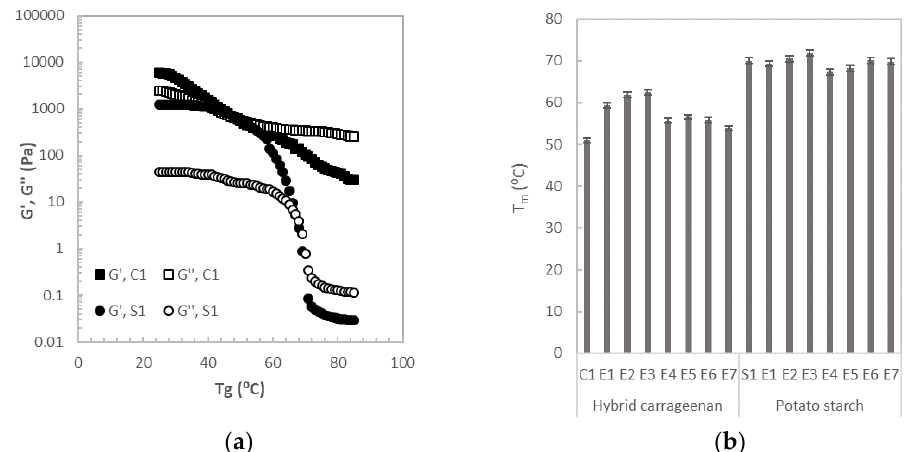
Figure 4. Heating profiles for ( a ) control matrices prepared with the hybrid carrageenan (C1) or potato starch (S1), as well as ( b ) the corresponding melting temperatures T m for all formulated matrices. Note than in this and subsequent plots, error bars were not presented whenever they were smaller than the symbol size.